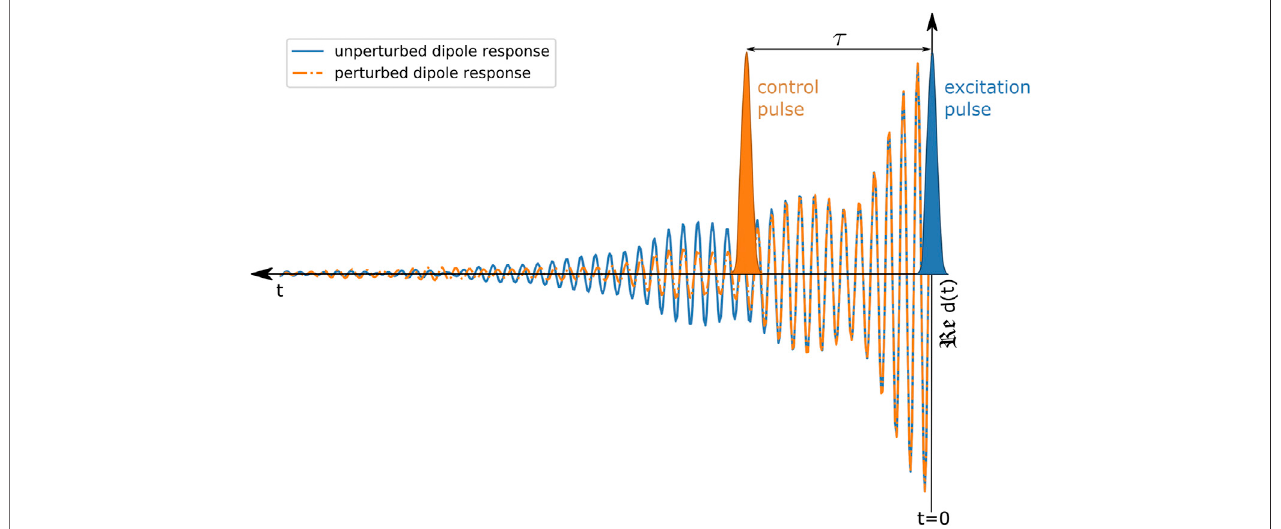
FIGURE1| Schematicillustrationofcontrollingtheopticaldipoleresponse.Theexcitationpulse(depictedinblue)initiatesthesystem ’ sdipoleresponse d ( t ) attime t (cid:1) 0 which thereafter evolves freely in time (blue solid curve) for t > 0. At time t (cid:1) τ a control pulse (depicted in orange) interacts with the dipole response, leading to a perturbeddipoleresponse(orangedashedcurve),whichthereafterdeviatesfromtheunperturbeddipoleresponse(evolvinginabsenceofthecontrolpulse)for t > τ .See also Ref. [14] for further discussions of this